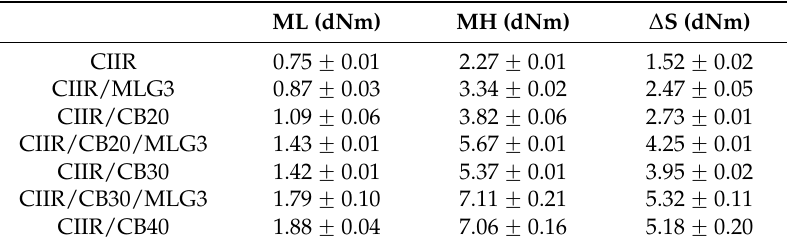
Table 3. Curing properties of CIIR and its